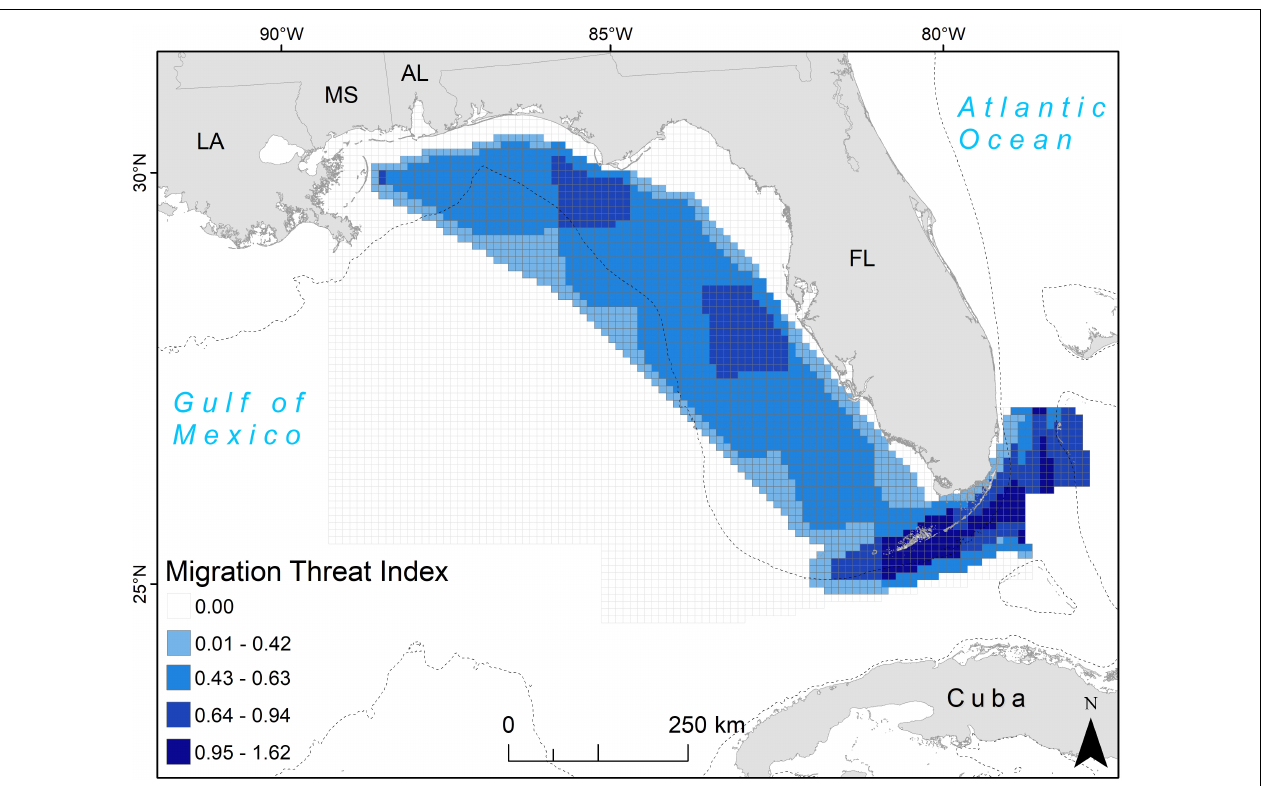
FIGURE 5 | Migration threat index for adult female loggerhead sea turtles ( Caretta caretta ; 64 tracks) after being tagged at nesting beaches throughout the Gulf of Mexico. The 10 km grid cells are color-coded by the threat index value, which accounts for the line KDE contour value in the cell and the value of three possible threats: commercial line fishing, shipping density, and shrimp trawling (see section Materials and Methods for more details). U.S. states are abbreviated: LA, Louisiana; MS, Mississippi; AL, Alabama; FL, Florida. The 200 m bathymetric contour is shown as a dashed